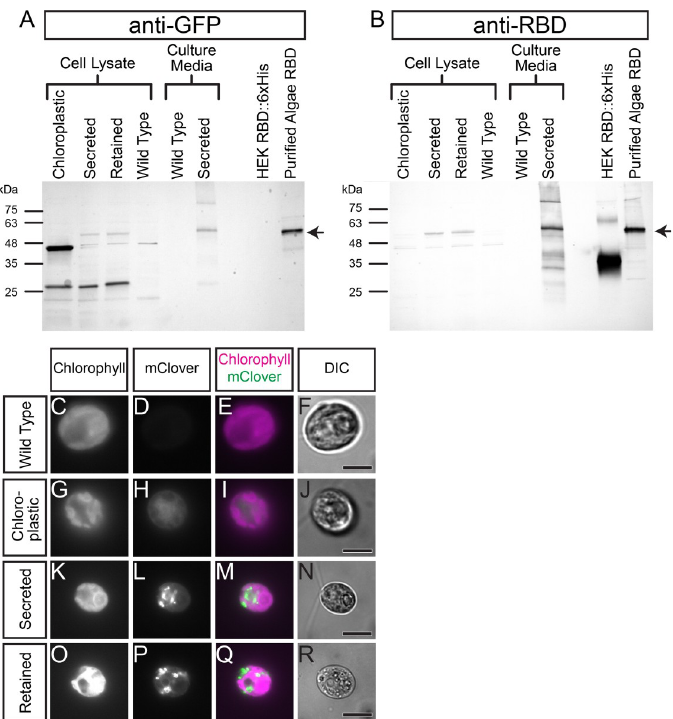
Fig 2. Characterization of RBD::mClover expression with different subcellular localizations. (A) Western Blot characterizing the expression of RBD::mClover in the cell pellet lysate or secreted supernatant of transformants from vectors pRMC1/2/3 by probing the blot with anti-GFP. 5 μ g of total protein from the cell pellets were loaded in to each well while a 10 μ L of 1:200 concentration of the cell culture supernatant or 5 μ L of partially purified Algae RBD:: mClover was loaded. 100 ng of HEK-cell produced RBD::6xHis tag was used as a control. A background band is observed at ~45 kDa in all samples including our wild-type control. The expected size of all RBD::mClover gene products is 51 kDa and is indicated by an arrow on the right-hand side of the blot. The gene product of the Chloroplast-directed version of our RBD construct appears as a strong band below the 48 kDa molecular weight marker while the Secreted or ER-Golgi retained versions appear above the 48 kDa marker. (B) A Western Blot with the same organization as before but probed with Rabbit anti-RBD polyclonal antibody. The Chloroplast-directed version of RBD::mClover does not appear to be detected while the Secreted and ER-Golgi retained versions are. A background band is observed in all samples including the wild type control at ~51 kDa. (C-R) Fluorescence and Differential Interference Contrast microscopy (DIC) images of wild type and RBD::mClover construct transformed C . reinhardtii cells. (G-J) The chloroplast-directed RBD::mClover shows little to no co-localization with the chlorophyll auto- fluorescence of the chloroplast. (K-R) The secreted and ER-Golgi retained versions of the RBD::mClover transgene show similar expression patterns and obvious localization to vesicles. Scale bars in DIC panels indicate 5 μ m.